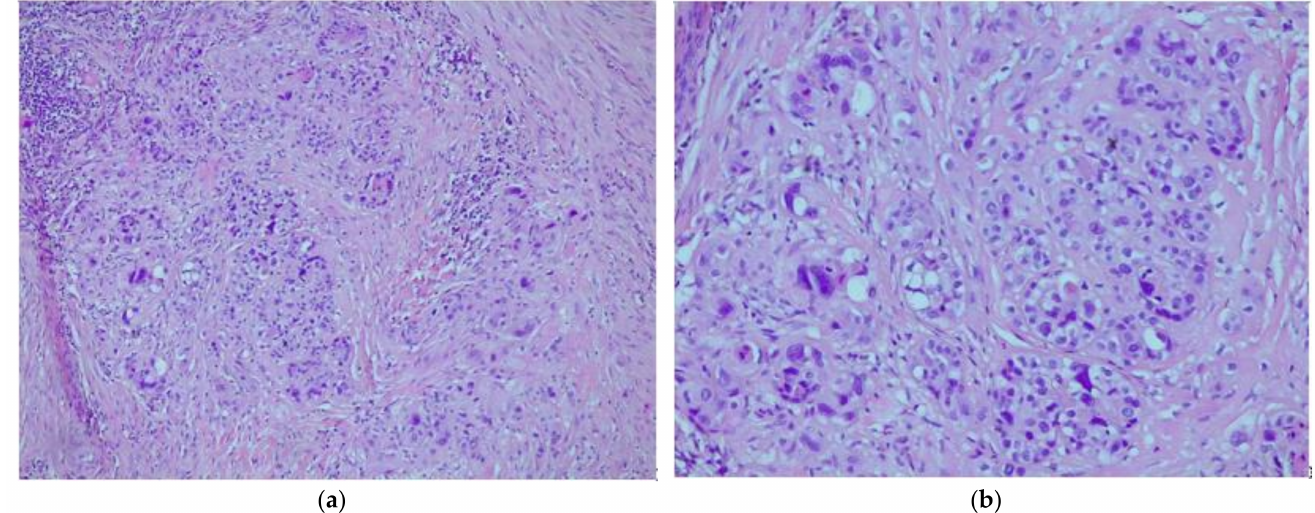
Figure 1. Histopathological exam of the sample (hematoxylin and eosin; H&E): ( a ) intermediate trophoblastic cells forming elongated structures and nests (H&E, 10 × ); ( b ) groups of the intermediate trophoblastic cells (H&E, 20 ×